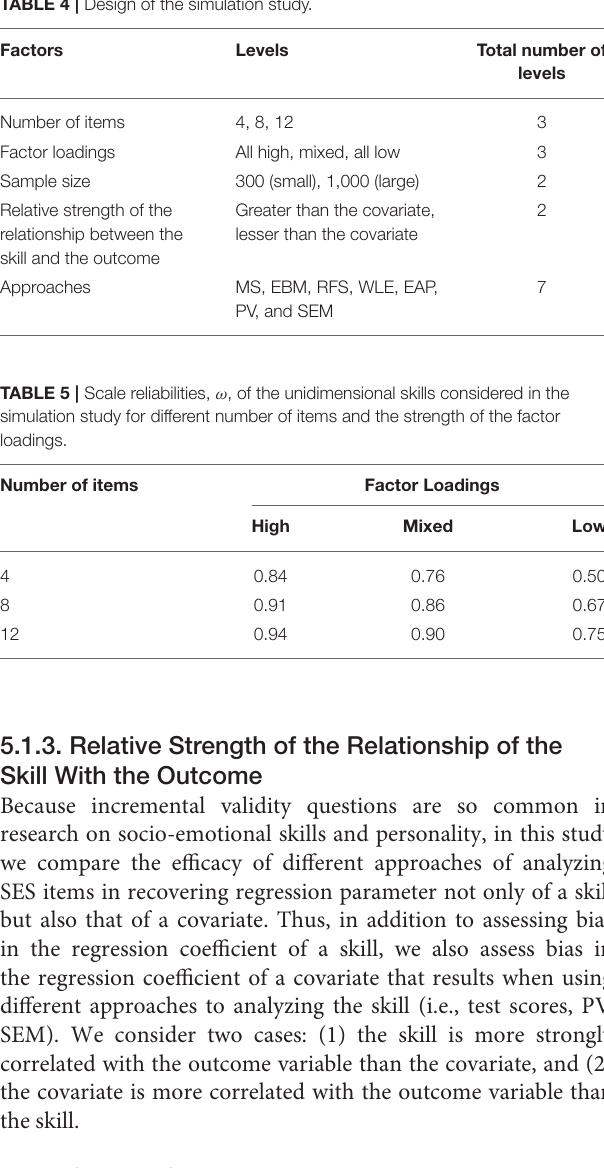
TABLE 4 | Design of the simulation study.